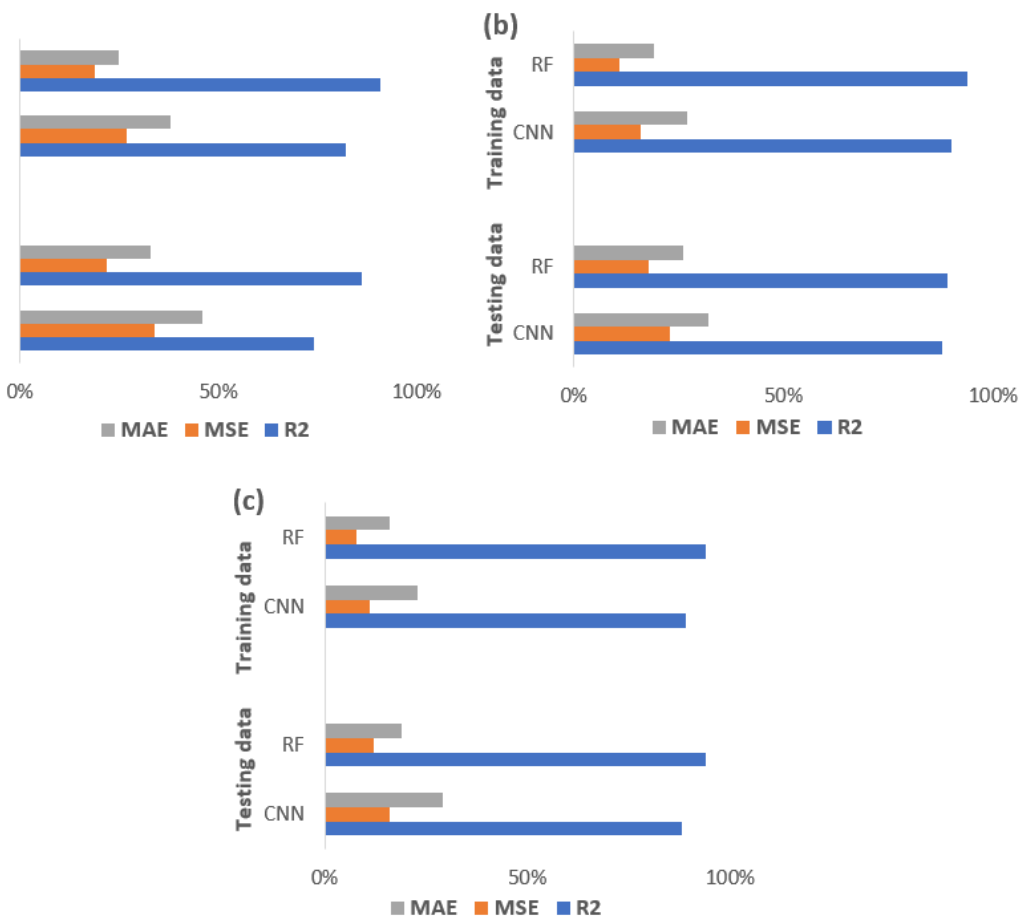
Figure 17. Comparison between convolutional neural network and random forest; (a) Surface roughness; (b) Shore D hardness; (c) Tensile strength.